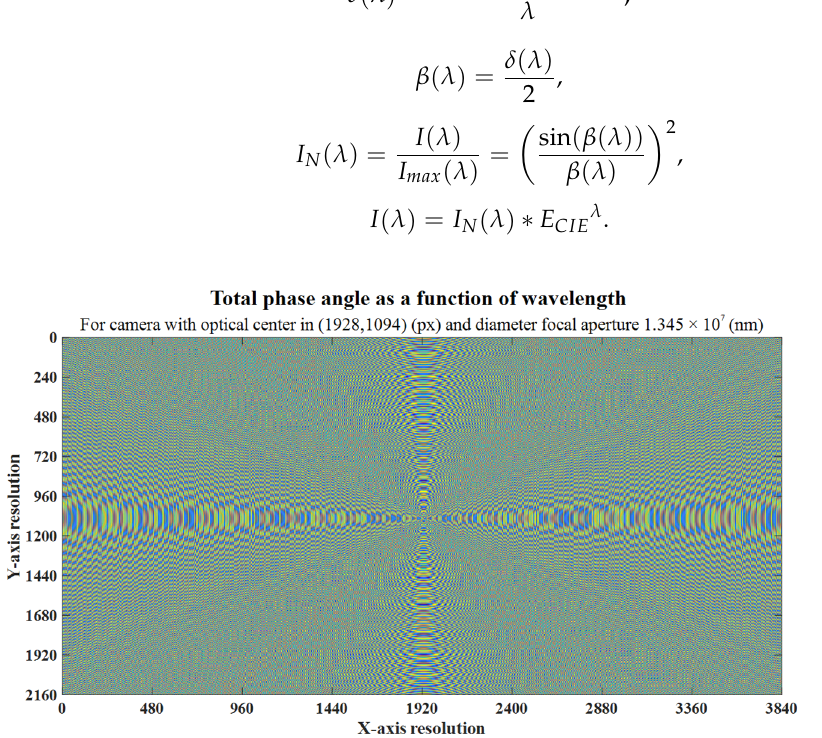
Figure 6. Quantum interference in the RGB sensor in GoPro Hero 5.